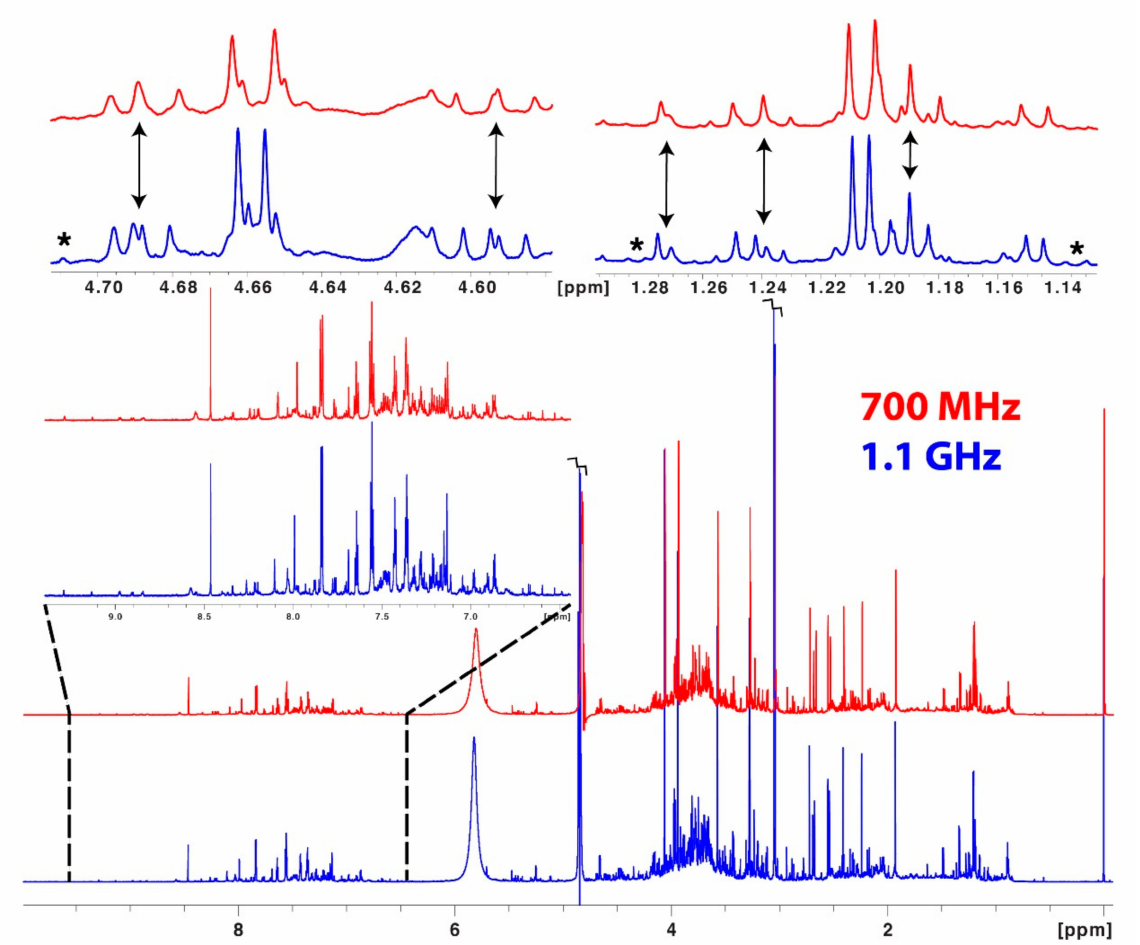
Figure 2. Expansions of experimental NMR data of the same sample of human urine collected in 5 mm tubes at 700 MHz (top red) and 1.1 GHz (bottom blue). For the 700 MHz data, the probe was a 5 mm quadruple resonance inverse CryoProbe (QCI-F). For the 1.1 GHz data, the probe was a 5 mm double resonance carbon-enhanced inverse (DCI) CryoProbe. The water suppression and baseline from the 1.1 GHz data are outstanding. This figure highlights some regions in which the increased chemical shift dispersion has resolved multiplets at 1.1 GHz compared to 700 MHz (indicated by arrows). There are also several small resonances that are difficult or impossible to recognize at 700 MHz that are clear at 1.1 GHz (indicated by *). Because the data were obtained with two types of probes and not fully relaxed, it is impossible to directly compare sensitivity gains across these datasets. Dr. Rainer Kuemmerle of Bruker BioSpin kindly provided the